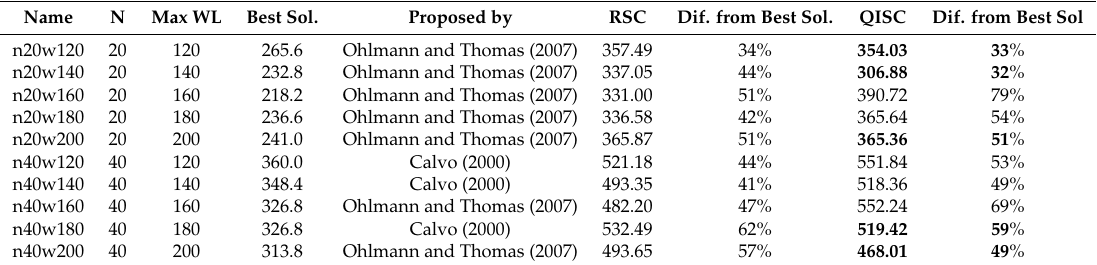
Table 1. Computational Results- RSC vs. QISC comparative study.